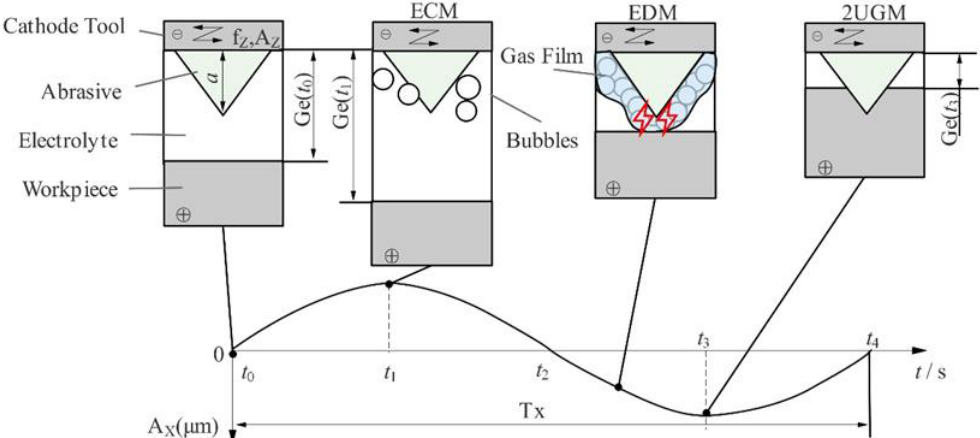
Figure 2. The machining process within a vibration cycle of the workpiece.